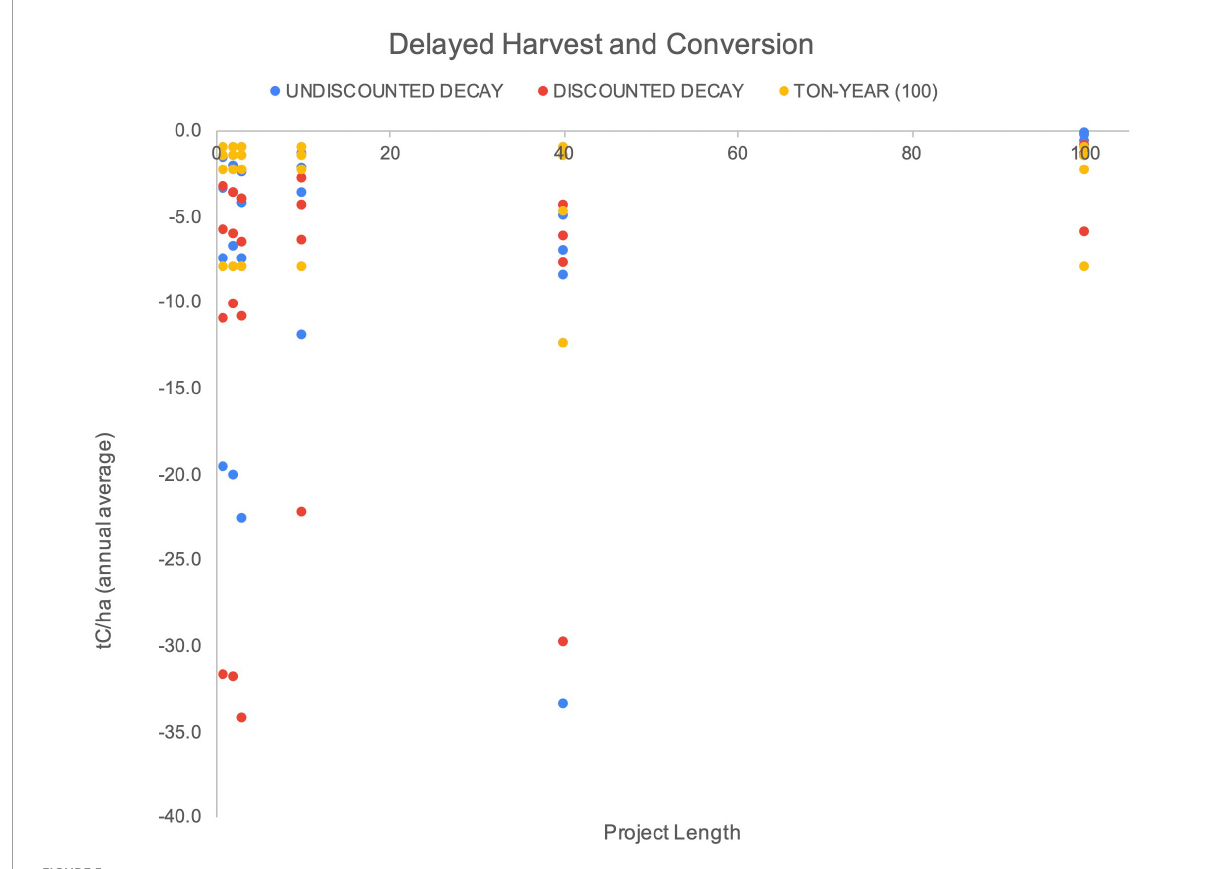
FIGURE5 Net flux (tC/ha) by project length for deferred harvest and conversion projects. Accounting approach and forest type for extreme values are indicated. Ton-year results reflect a 100-year time horizon. Negative values represent net sequestration relative to a baseline, immediate-harvest